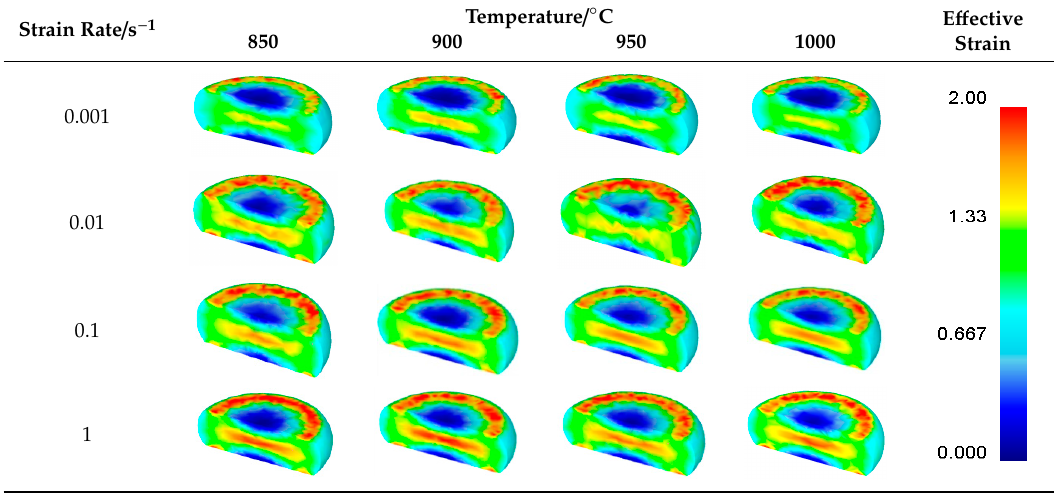
Table 3. The distribution of effective strain modeled by FEM for TB8 titanium alloy deformed at the strain of 0.8.